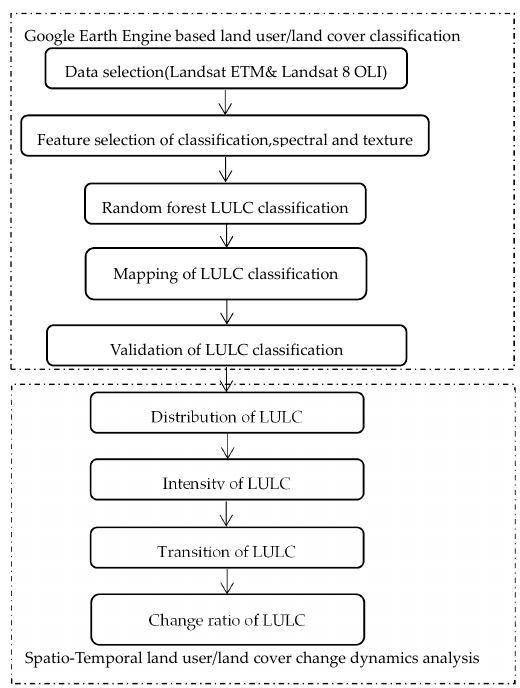
Figure 2. Flowchart of GEE-based LULC classification and change analysis.